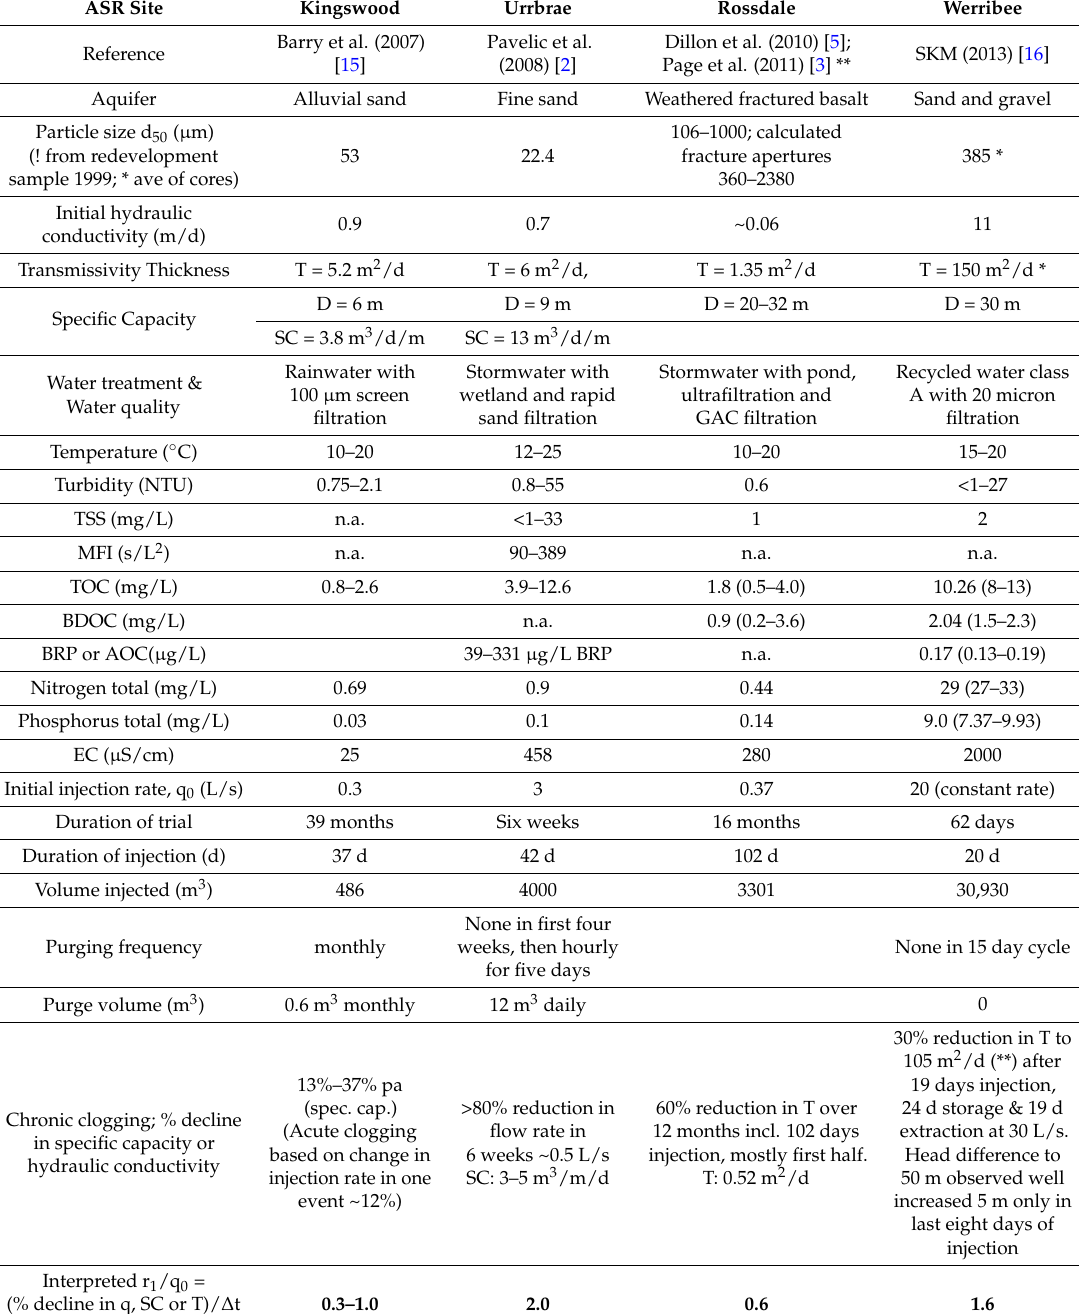
Table 5. Results of four Australian injection trials and observed clogging rates in siliceous aquifers.